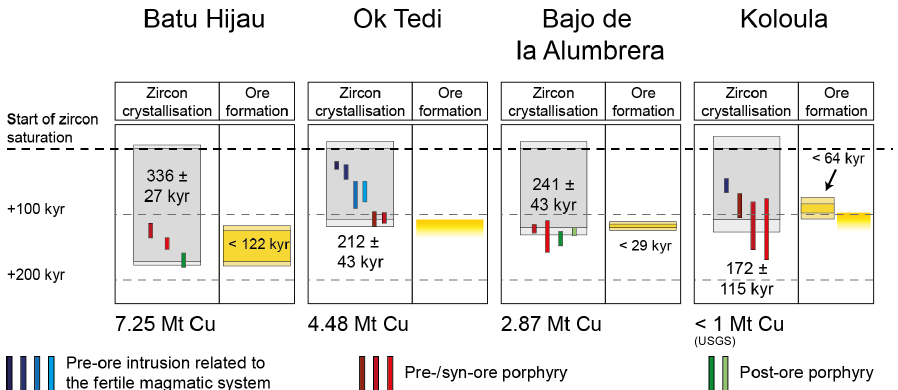
Figure 9. Overview of high-precision geochronology studies on porphyry deposits. Data for Ok Tedi, Bajo de la Alumbrera and Koloula are from Large et al. (2018), Buret et al. (2016) and Tapster et al. (2016), respectively. Coloured vertical bars are emplacement ages of different intrusive rocks described from these deposits. Intrusions are categorised as pre-ore, pre- and syn-ore, and post-ore intrusion. Deposit size decreases from left to right (tonnages from Cooke et al., 2005). Diagrams are aligned so that the onset of zircon crystallisation overlaps in all deposits. Grey bars indicate the recorded duration of zircon crystallisation. Yellow bars illustrate the maximum durations of total ore formation or individual ore formation pulses. The yellow bar fading out downwards indicates the absence of a post-ore intrusion and the inability to constrain the total duration of ore formation. Note that we excluded the sample X176 from Koloula as it is not related to magmatic history leading to ore formation (Tapster et al.,